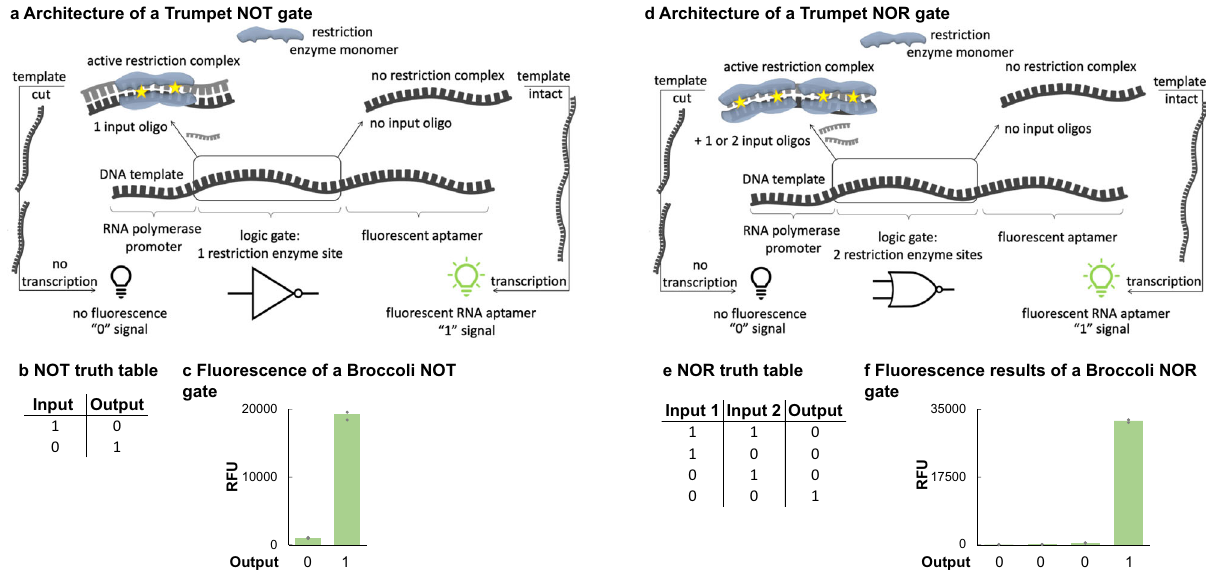
Fig. 3 | Trumpet NOT and NOR gates. a The general architecture of a NOT gate. The NOT gate only requires one input, a 26-base single-stranded DNA that is complementary to the region with the restriction enzyme cut site on the gate template.Whenthe inputispresent(left),ithybridizeswiththegate template.The restrictionenzymerecognizesthecutsiteandcleavesthegatetemplate,separating the promoter from the aptamer. The T7 RNA polymerase cannot transcribe the aptamer, and the lack of fl uorescence is recorded as a 0 signal. When the input is notpresent(right),therestrictionenzymecannotcutthesingle-strandedtemplate. TheT7cantranscribetheRNAaptamerfromtheintactgatetemplate,whichresults in a fl uorescence signal recorded as a 1. b A NOT gate truth table. c Fluorescent table. f Fluorescent results of a NORgate. On all panels, the value of each replicate